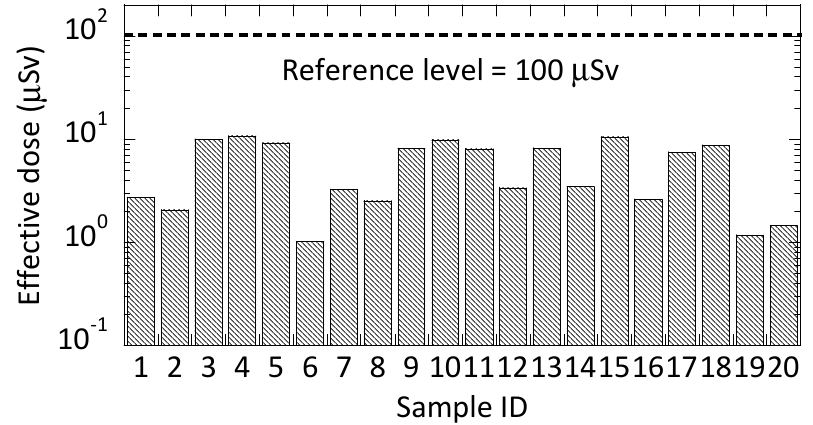
Figure 3. The maximum annual e ff ective dose in each bottled water sample compared to the guidance level.